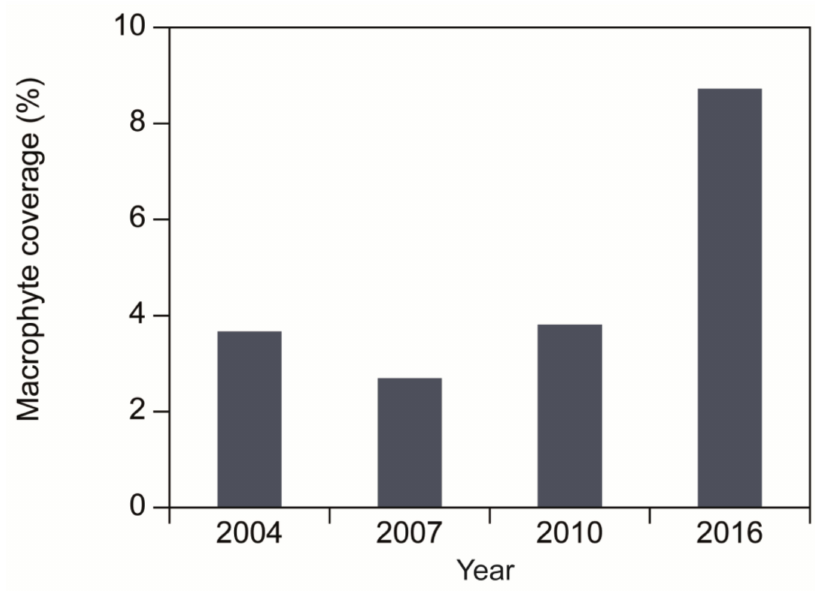
Figure 7. Plant coverage in percent of lake area (lake area = 319